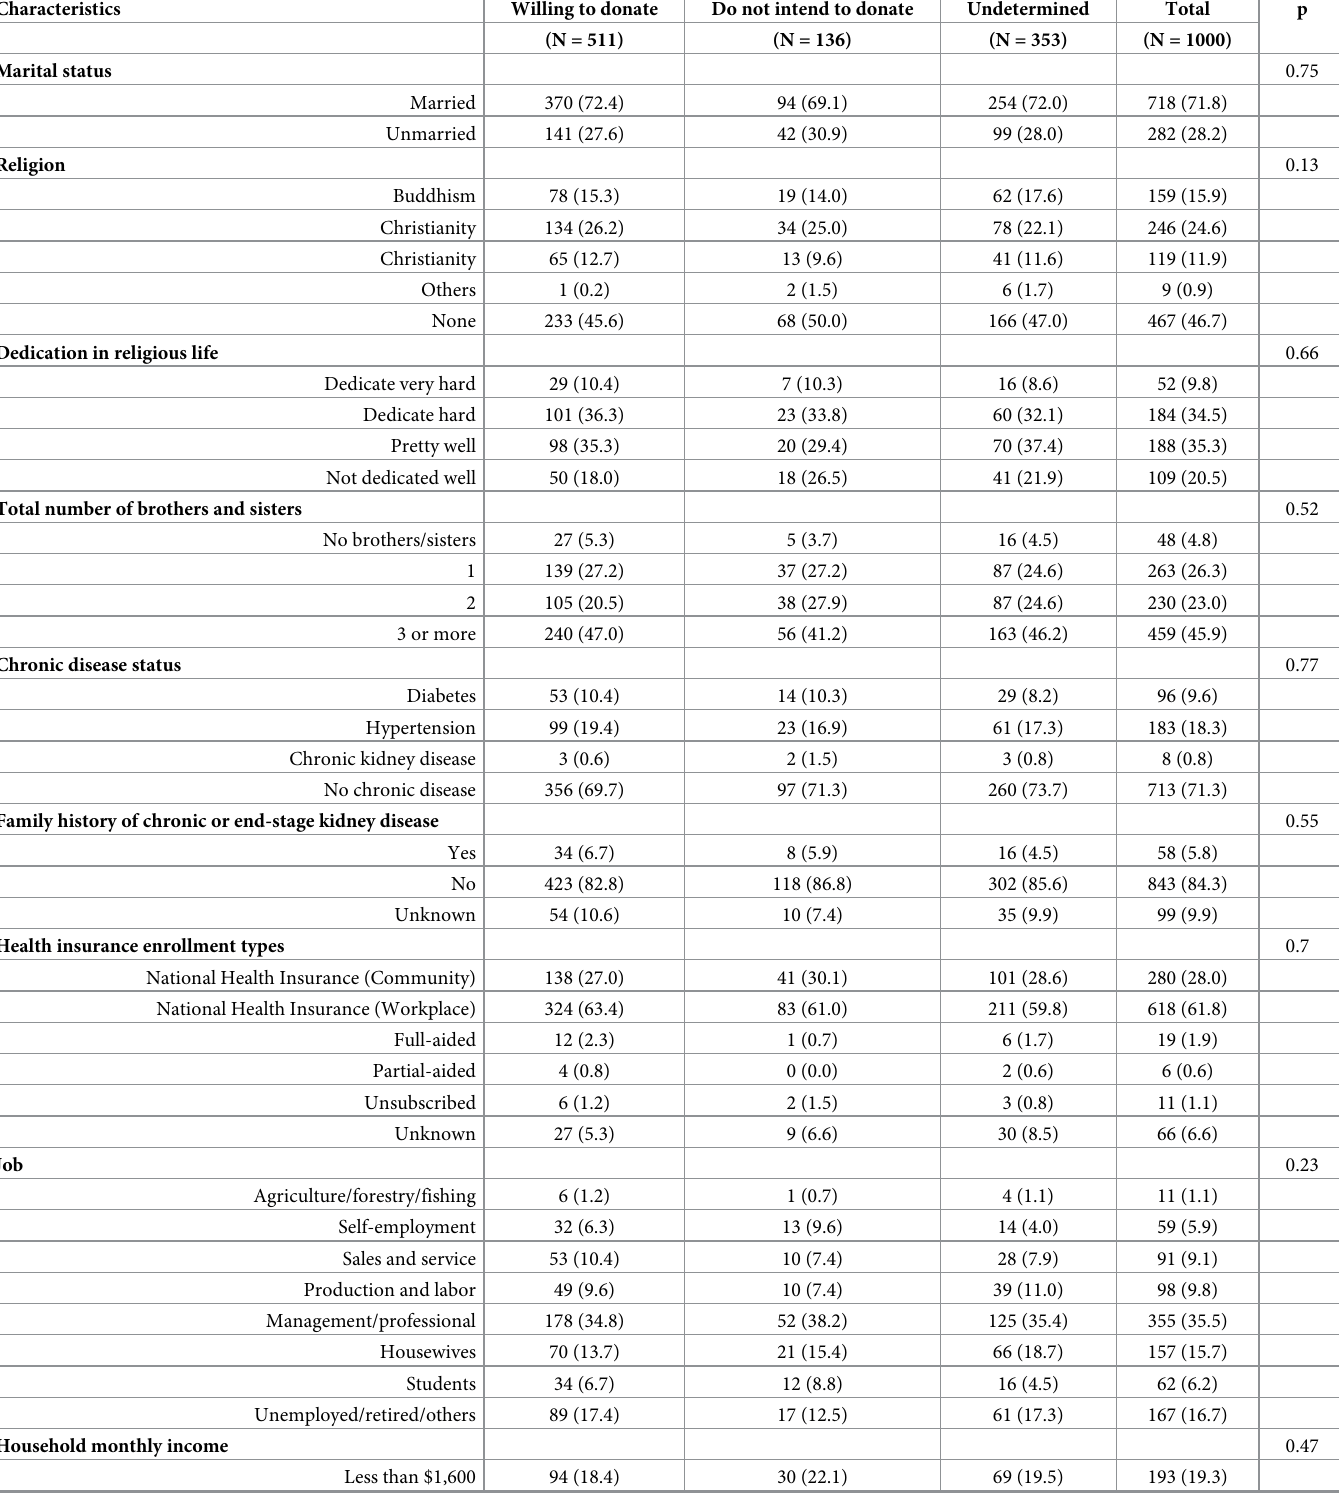
Table 2. Characteristics according to willingness of kidney donation a .